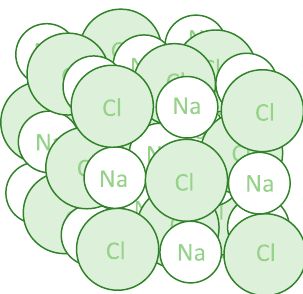
Figure 1. Three-dimensional structure of the sodium chloride crystal. Each sodium ion is octahedrally surrounded by six chloride ions, and each chloride ion is octahedrally surrounded by six sodium ions.